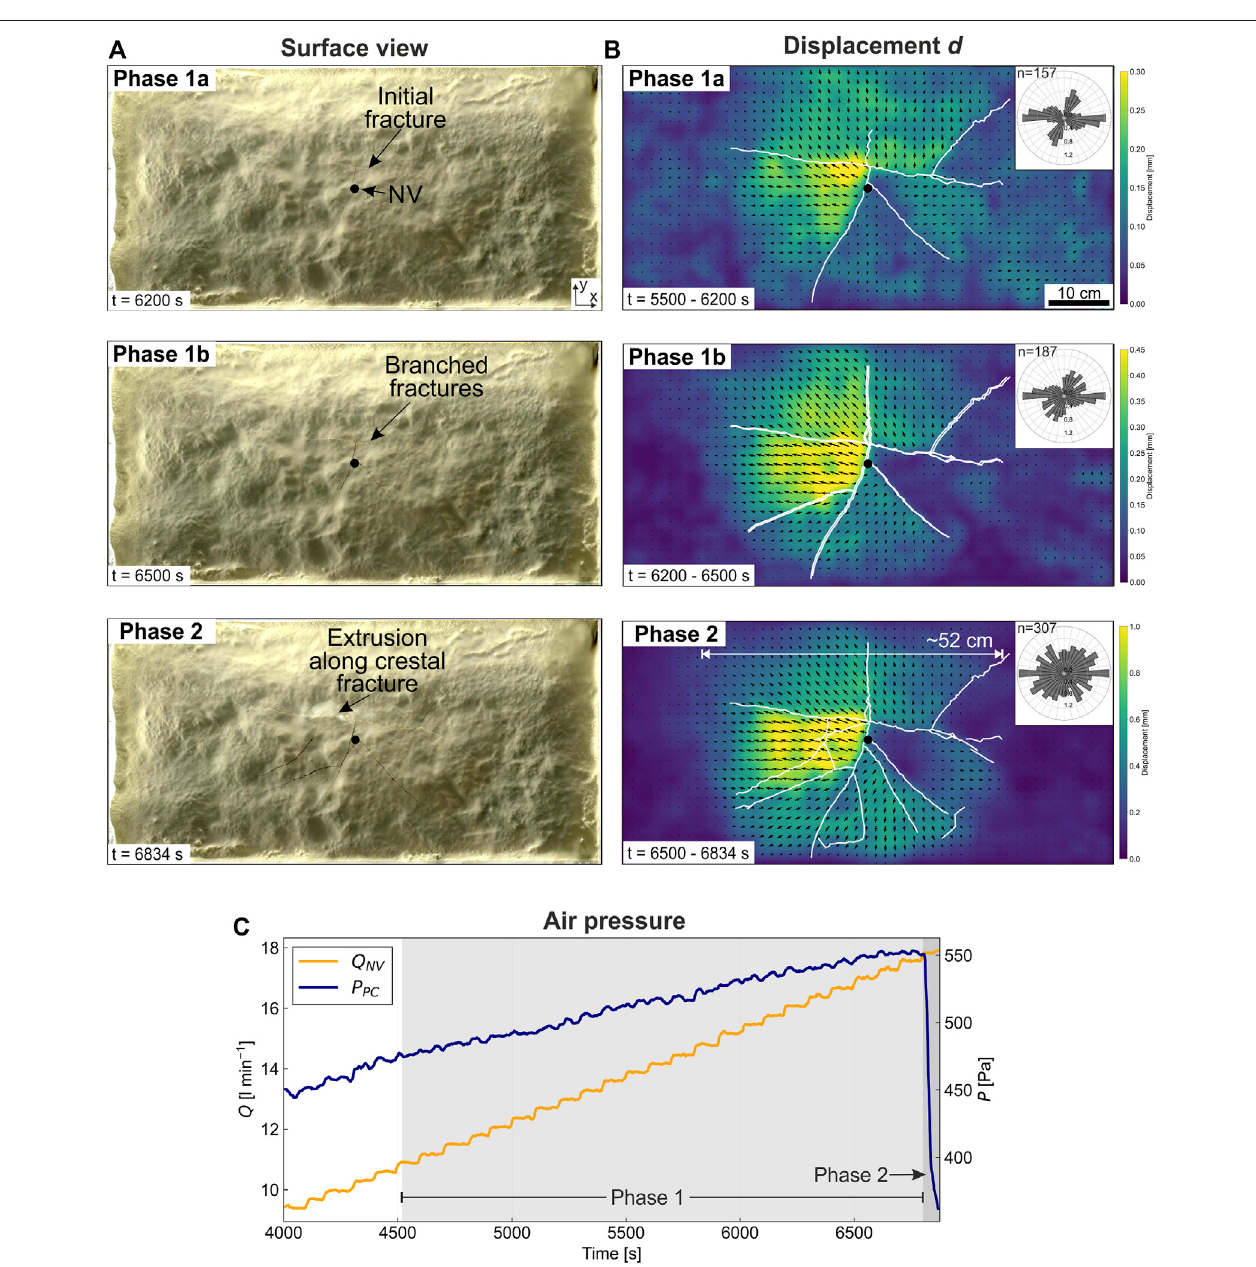
FIGURE5| Resultsofexp.1B,whichconsistedofahomogeneouscoverlayerandwasperformedinthe3Dboxcon fi gurationoftheapparatus. (A) Topviewofthe experimental surface. Phase 1a: initial, central fractures formed above the tip of the needle valve (NV). Phase 1b: Further fracture branched off from the initial fractures. Phase 2: branched fractures developed and material extrusion occurred along the central fracture. (B) Displacement vector fi eld derived from the DIC analysis. The background color displays the amount of the total displacement d . Each image shows the cumulative displacement for the speci fi ed time interval. The rose diagrams show the strike directions normalized by the lengths of individual fracture segments (white lines). (C) Time series of the air fl ux through the needle valve ( Q NV ) andthepressureinthepressurechamber( P PC ).Air fl uxatthebaseofthepressurechamber( Q PC )wasconstantsothat P PC wasapprox.40%ofthetotalverticalnormal stress at the beginning of the experiment ( Table 1 ).